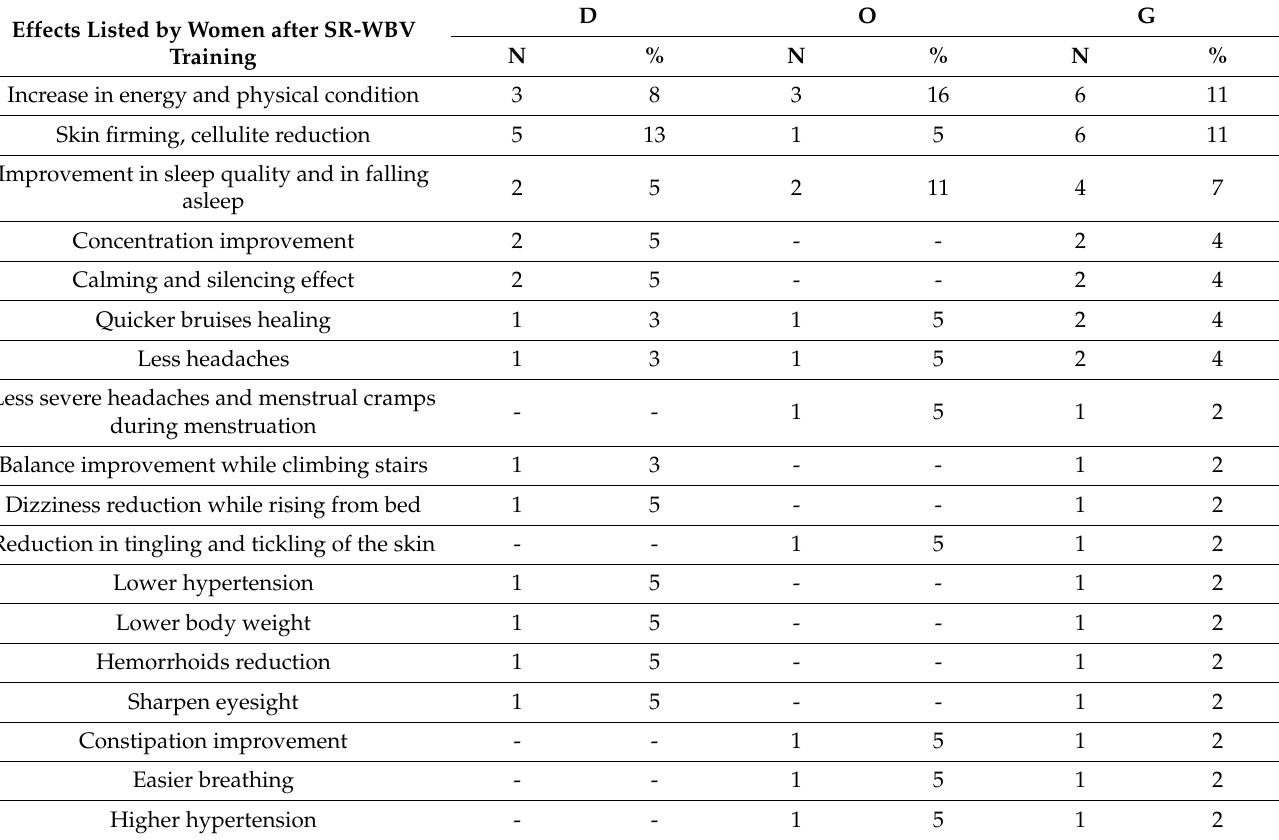
Table 2. Percentage of women declaring different effects of SR-WBV training in the D program (N = 38), O program (N = 19), and G program (altogether, N =